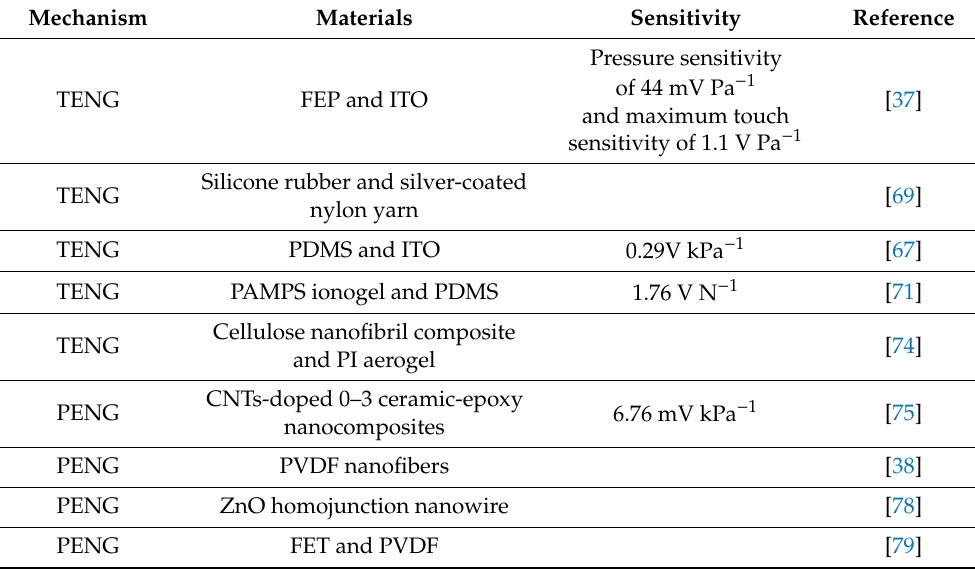
Table 2. Comparison of self-powered skin sensors for detecting touch and